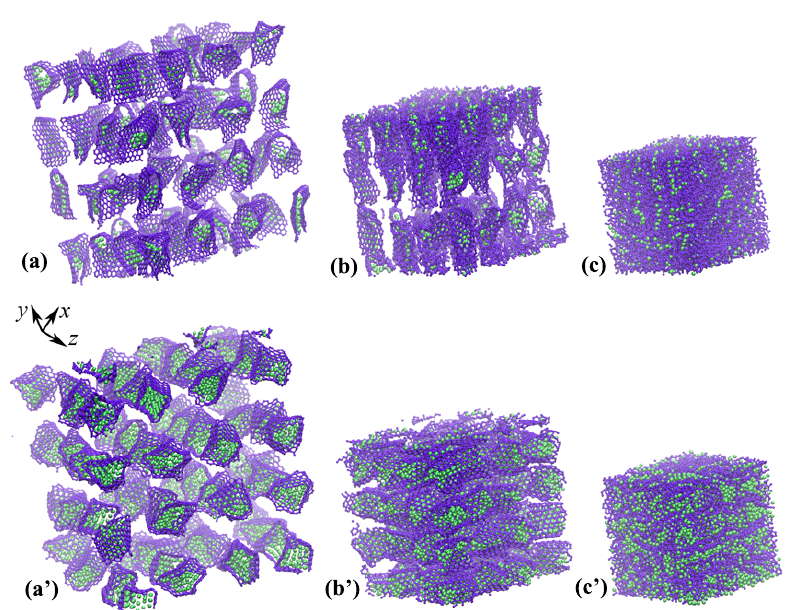
Figure 4. Snapshots of the structure of crumpled graphene filled with ( a – c ) Ni 21 and ( a’ – c’ ) Ni 78 nanocluster. Initial structure was obtained by annealing at 300 K, while composite was obtained by hydrostatic compression at 1000 K. Ni atoms are shown by purple and C atoms are shown by green